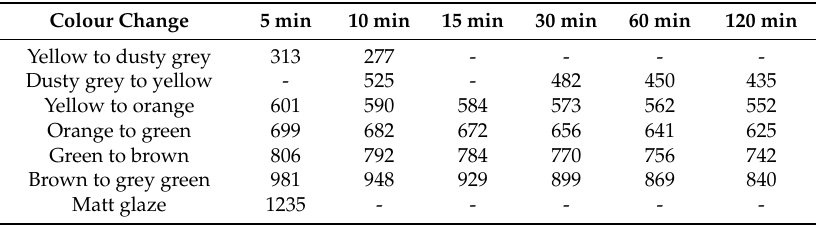
Table 1. Thermal paint temperature ( ◦ C) indication as function of time.